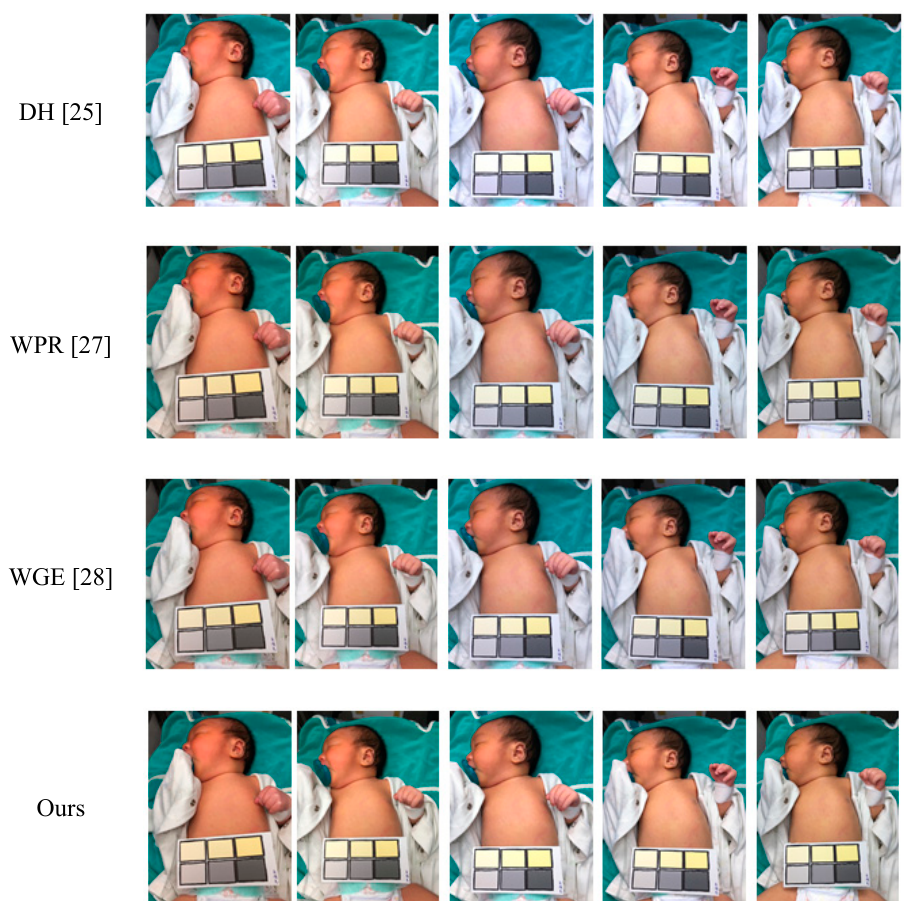
Figure 10. Adjusted resulting images of different color temperatures (32 K, 40 K, 48 K, 56 K, 65